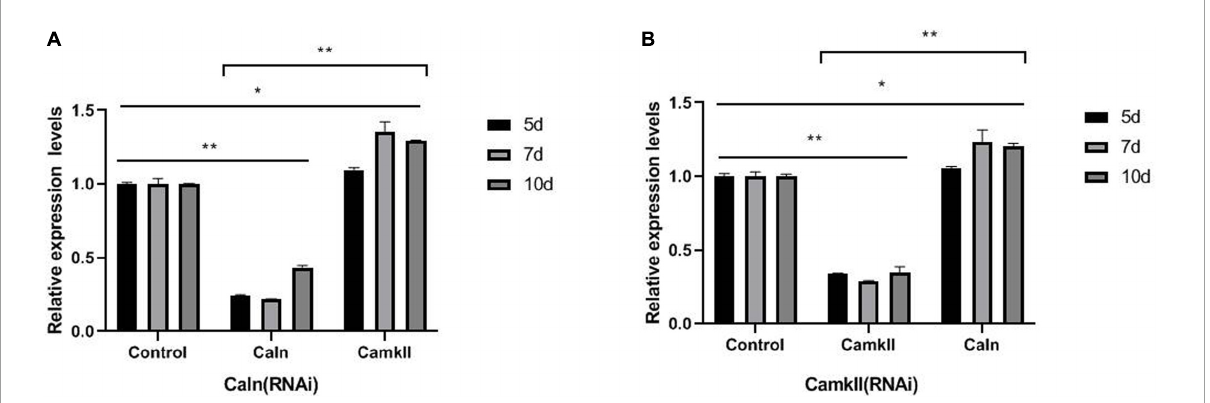
FIGURE1 Regulatory relationship between DjCaln and DjCamkII mRNA during planarian head regeneration. (A) DjCamkII mRNA levels in DjCaln (RNAi) planarians at 5, 7, and 10 days during planarian head regeneration, n = 4. (B) DjCaln mRNA levels in DjCamkII (RNAi) planarians at 5, 7, and